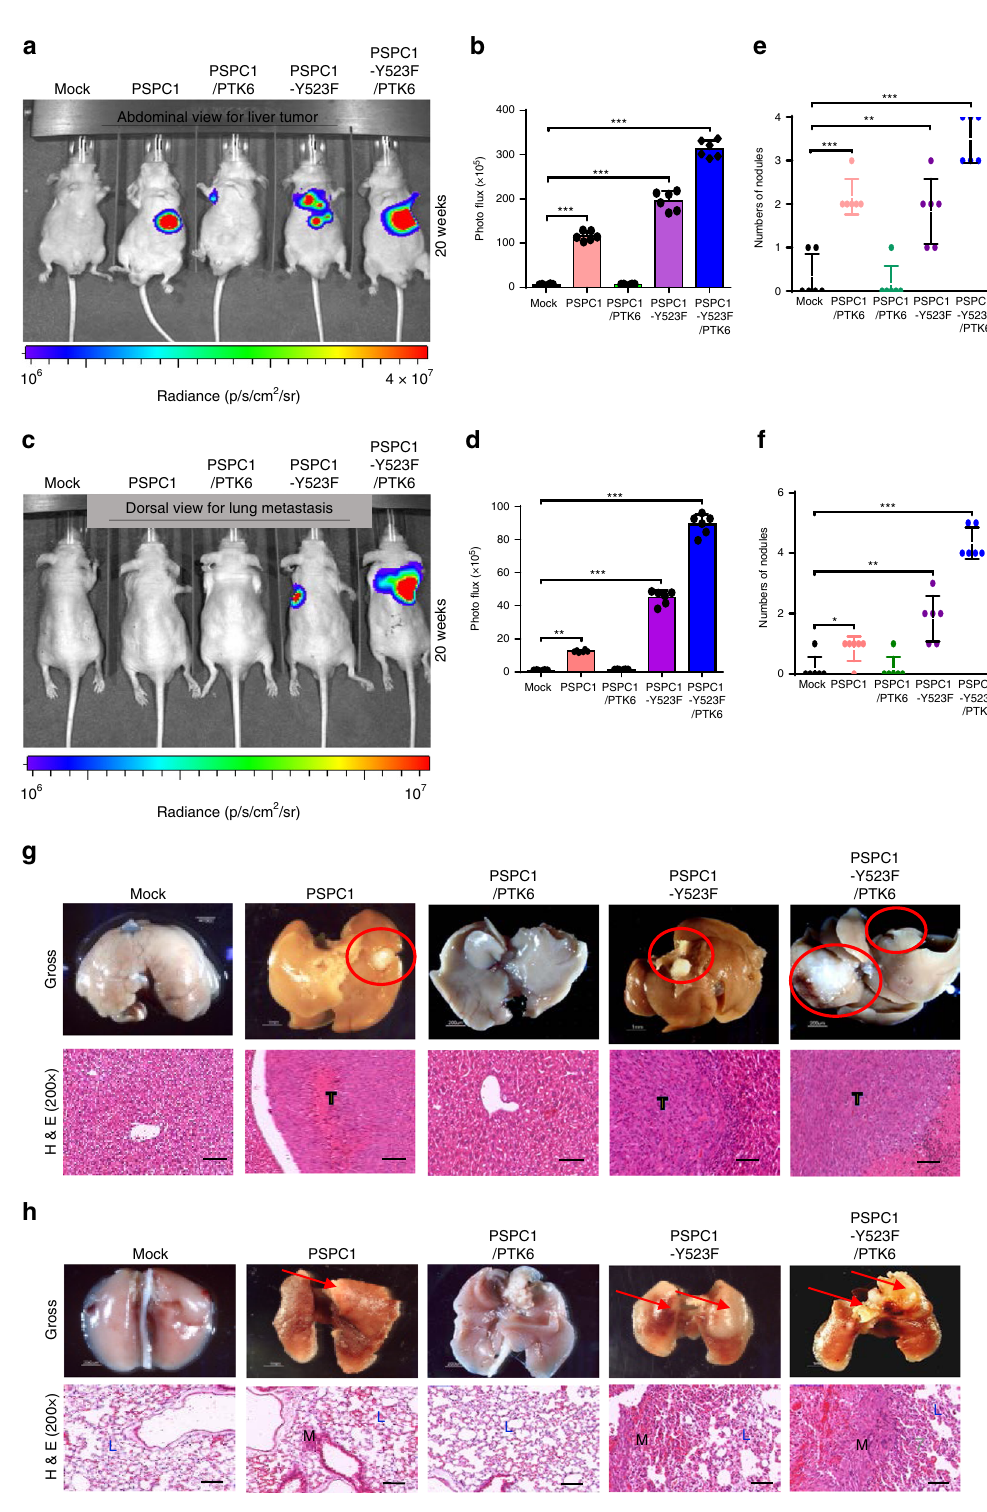
Fig. 4 The PSPC1/PTK6/ β -catenin axis is critical for tumor growth and metastasis in HCC. a – f Effects on tumorigenesis (abdominal view for measuring liver tumors) ( a , b ) and metastasis (dorsal view for measuring lung metastatic tumors) ( c , d ) of the PSPC1/PTK6 interaction and PSPC1-Y523F mutant in orthotopic mouse HCC model generated by SK-hep1 transfectants bearing luciferase expression constructs. The effects were measured by representative bioluminescence images ( a , c ), intensity of photon fl ux representative of tumor size at 20 weeks ( b , d ), and numbers of nodules in tumors at 20 weeks ( e , f ). Data represent the mean ± SEM ( n = 6/group). The PSPC1-Y523F mutant further enhanced tumorigenesis and metastasis in comparison with PSPC1 transfectants. All data statistics were based on * p < 0.05, ** p < 0.01, and *** p < 0.001 calculated by one-way ANOVA with Bartlett ’ s test. g , h Representative images of livers and lungs showing tumorigenesis and metastasis (top panels) and hematoxylin and eosin-stained images of tumors from liver ( g ) or lung ( h ) isolated from representative mice, respectively. Red circles indicate locations of primary tumor nodules; red arrows indicate lung metastasis nodules; T, tumor; L, lung; M, metastasis. The scale bar represents 100 µ m. Source data are provided as a Source Data fi